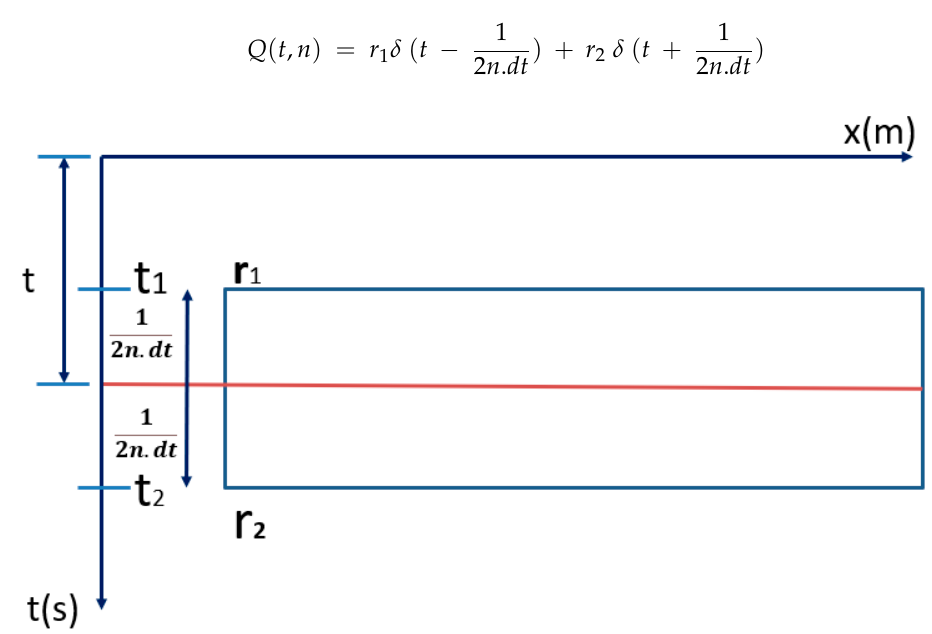
Figure 7. Locating the analysis point at the center of the layer (red horizontal line).